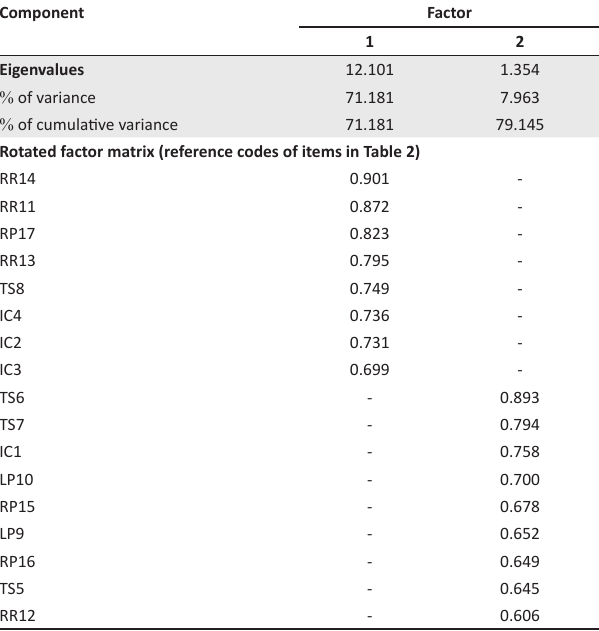
TABLE 4: Eigenvalues and rotated factor matrix.